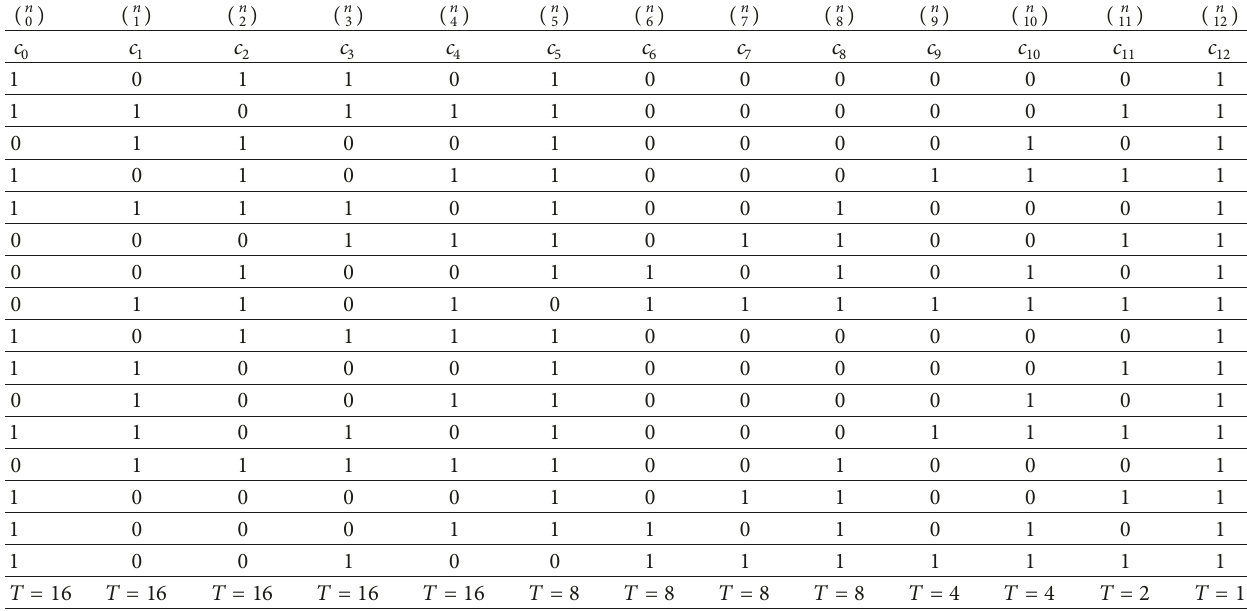
Table 5: Binomial representations of the 16 shifted versions of the sequence {( 𝑛 0 ) + ( 𝑛 2 ) + ( 𝑛 3 ) + ( 𝑛 5 ) + ( 𝑛 12 )}